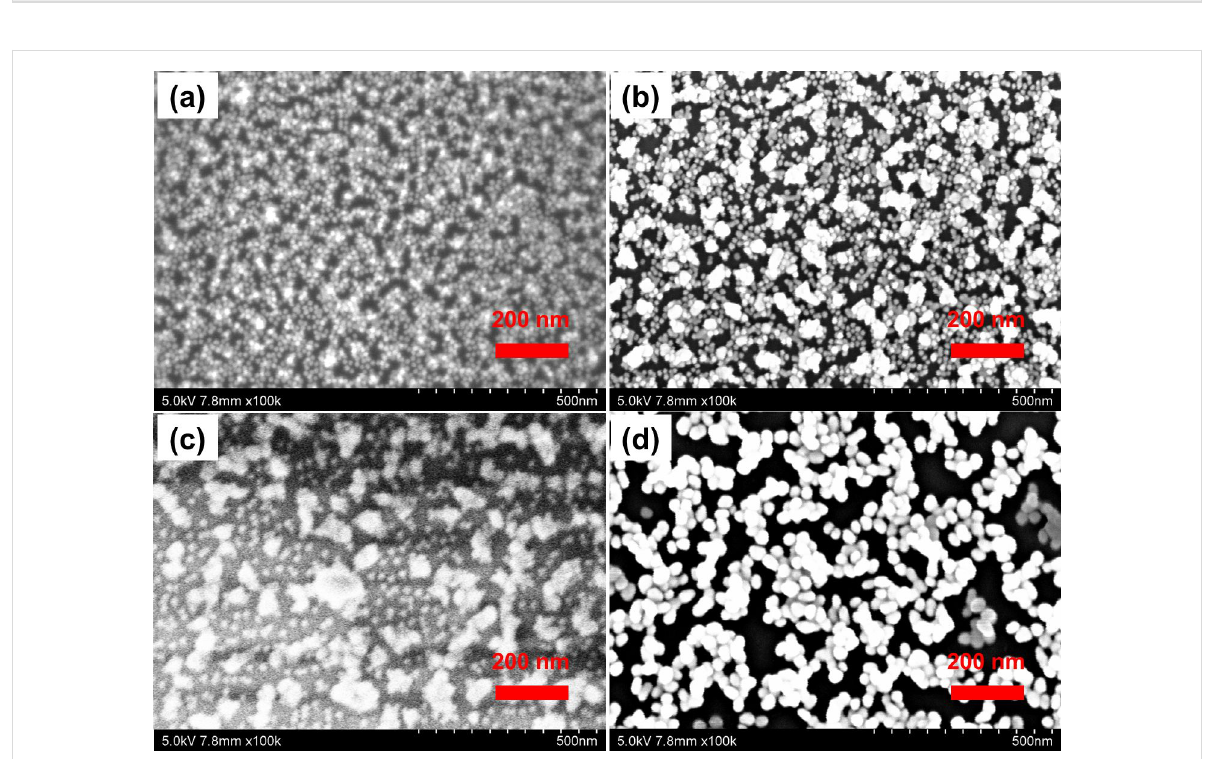
Figure 2: SEM images of multilayer thin films consisted of PDDA and Au NPs of different sizes: (a) SSS, (b) SBS, (c) BSB, (d)